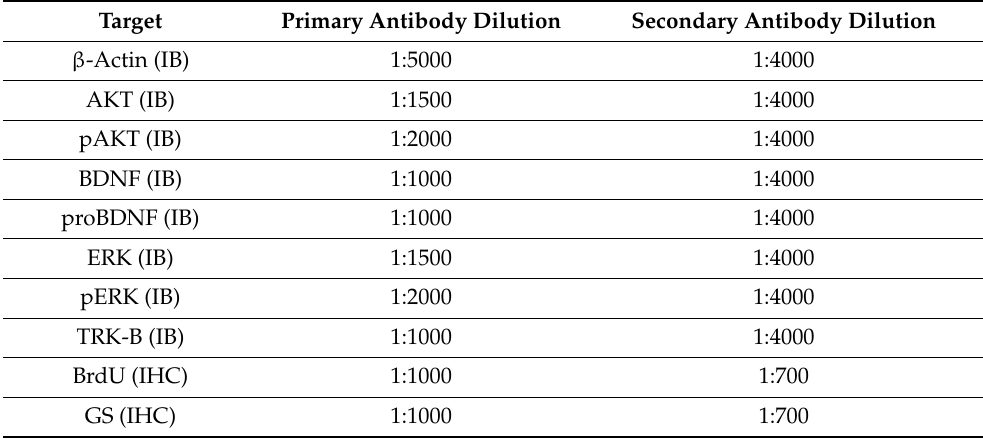
Table 1. Measurement of BDNF concentration with enzyme-linked immunosorbent assay (ELISA) was performed using a Due ELISA Set (#DY248) from R&D System (Minneapolis, MN, USA), according to the manufacturer’s instruction. Table 1. Antibody dilution factors in immunoblotting (IB) and immunohistochemistry ((HC).